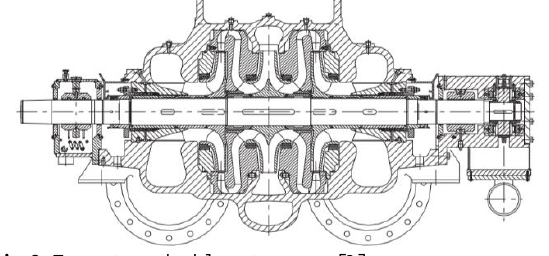
Fig. 3. Two-stage, double-entry pump [2]